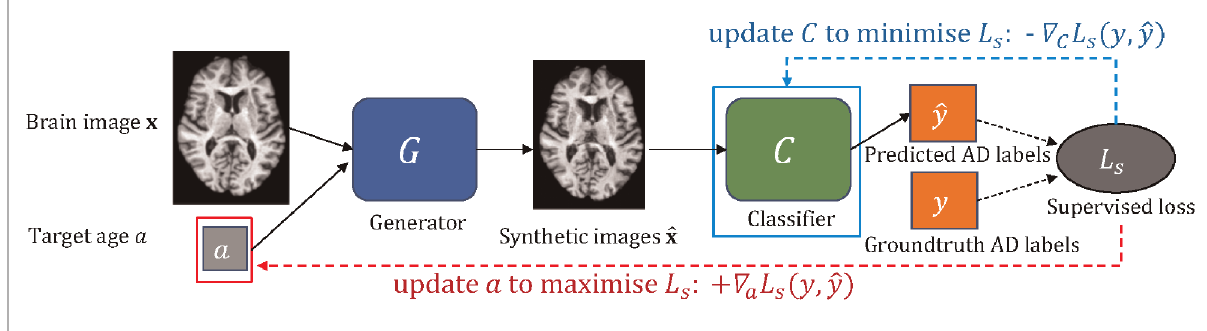
FIGURE 1 A schematic of the adversarial classi fi cation training. The pre-trained generator G takes a brain image x and a target age a as input and outputs a synthetically aged image ^ x that corresponds to the target age a . The classi fi er C aims to predict AD label for a given brain image. To utilise G to improve C , we formulate an adversarial game between a (in red box) and C (in cyan box), where a and C are updated alternatively and iteratively using L 1 and L 2 , respectively (see Section 2.3 ). Note G is